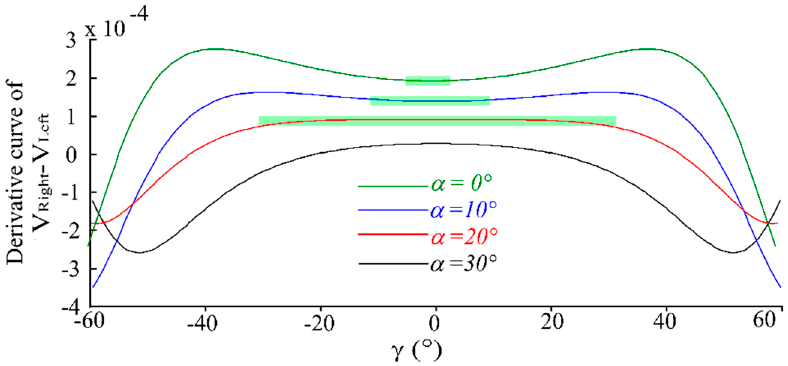
Figure 8. Derivative curve of V right − V Left . ( α is 0°, 10°, 20°, 30°, respectively, p is 0 μ m, h is 500 μ m).